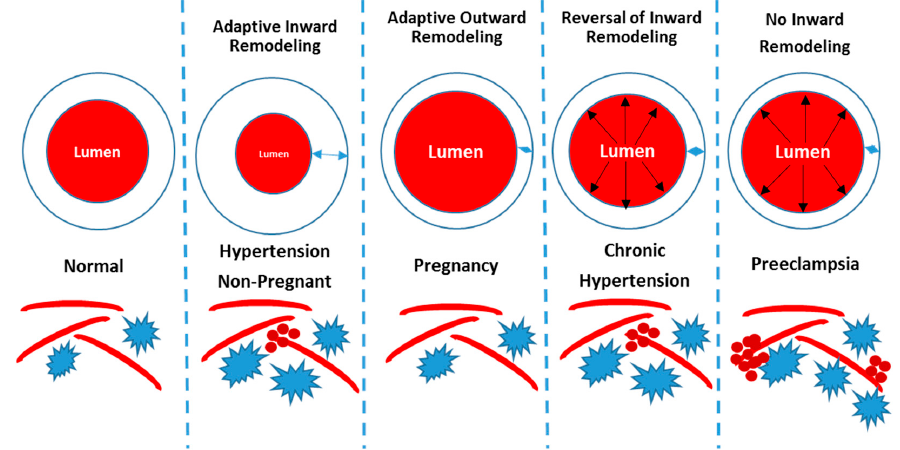
Figure 4. Summary of cerebrovascular changes associated with hypertension, pregnancy, and preeclampsia. In the hypertensive, non-pregnant state, wall thickness increases and lumen diameter decreases. In pregnancy, there is an adaptive outward remodeling while in preeclampsia, there is a lack of inward remodeling in response to hypertension, causing cerebral blood vessels to be more susceptible to blood brain barrier (BBB) disruption and micro-bleeds. In chronic hypertension, pregnancy reverses the in-ward remodeling of the cerebral vessels. Increased blood pressure and velocities in vessels with thin walls can cause transmittal of pressure to the micro-vessels causing BBB leakage and micro-bleeds. This induces increases in glial cells and chronically, neuroinflammation. Tube-like structures represent capillaries, star-shaped cells represent glia, and red mini-circles represent